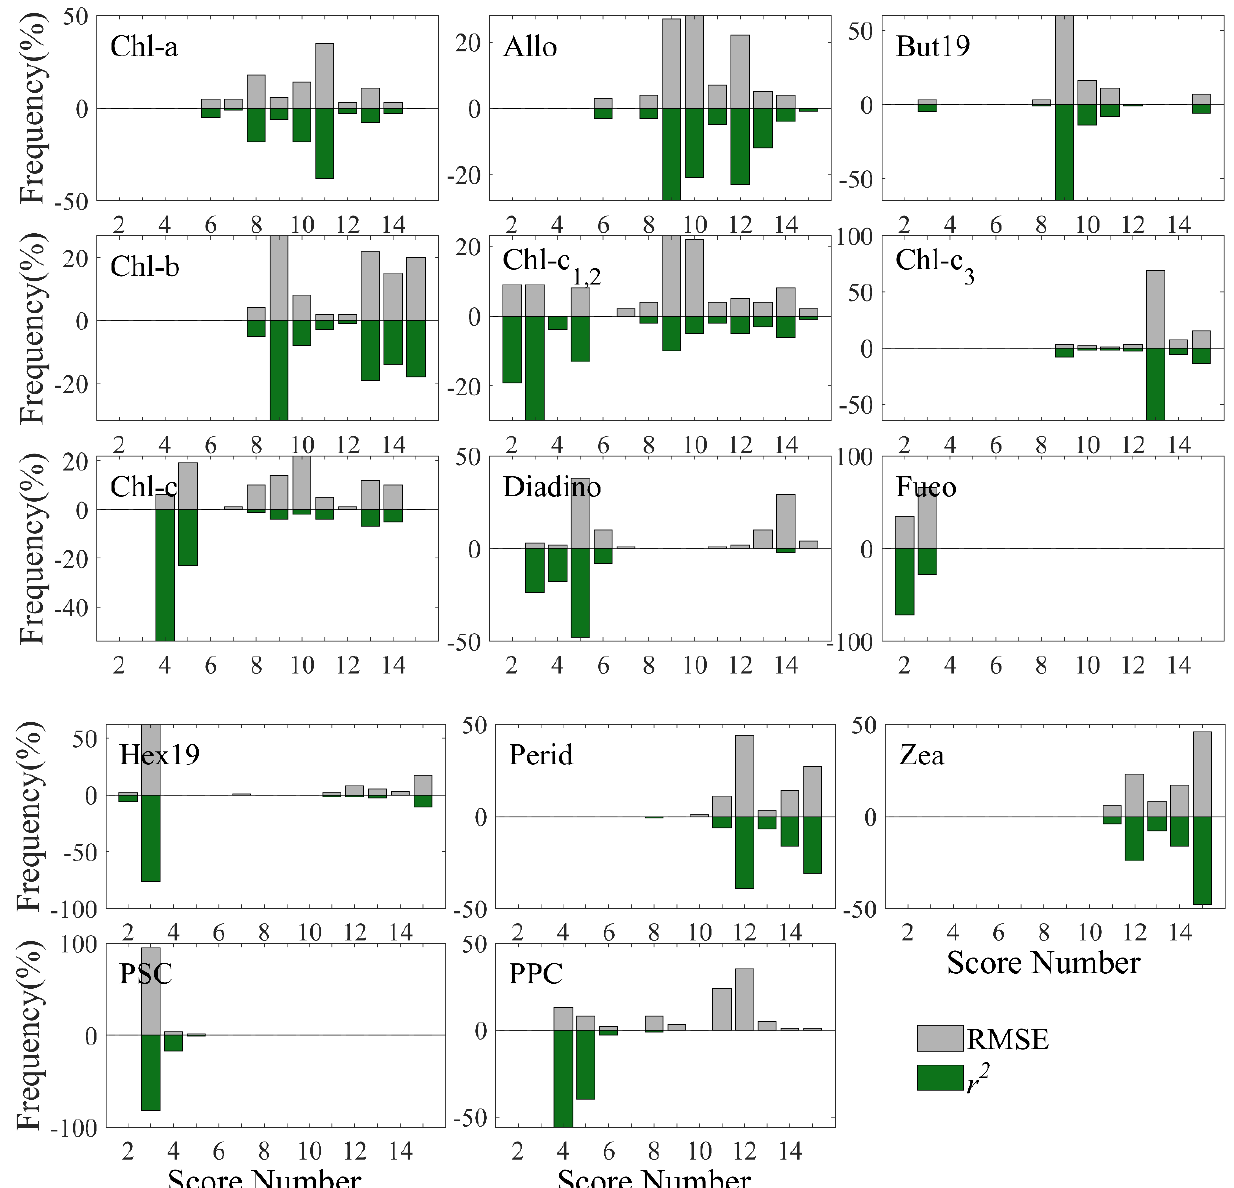
Figure 3. Example of selection of a number of principal components calculated based on a B ( λ ) . The frequency of the minimum RMSE (gray column) and the frequency of the maximum r 2 (green column) was calculated from 100 permutations for each pigment. The negative sign simply represents another type of parameter.